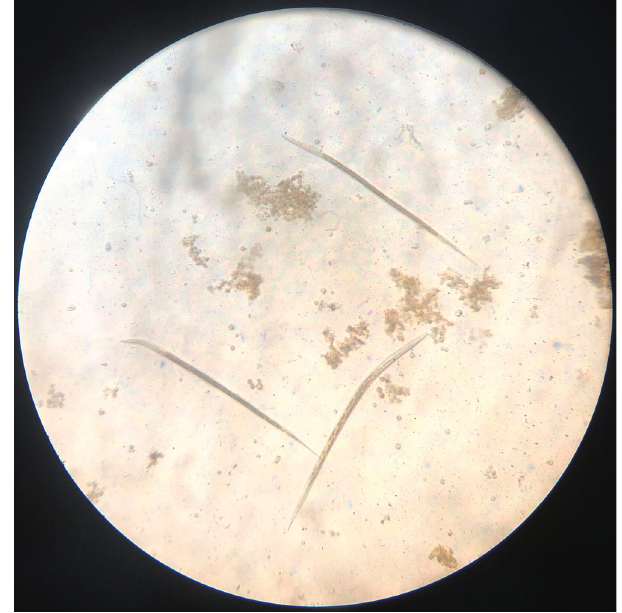
Figure 7: Chabertia sp. (tail of sheath very long, larva of medium size, 24 – 32 square gut cells, and lumen of gut straight). Third- stage